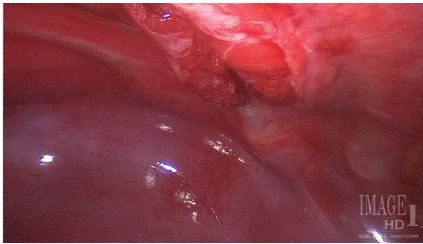
Figure 3: Thoracoscopic image of the pulmonary hernia at the lateral 7th intercostal